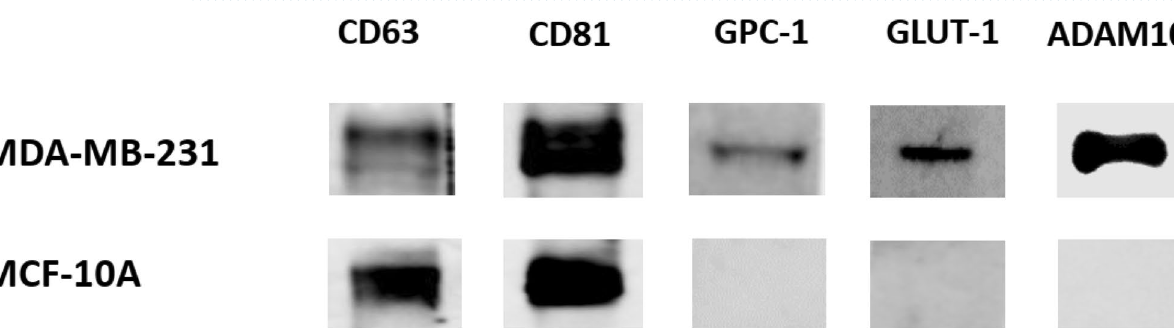
Figure 3. The relative abundance distribution of the 15 potential BC biomarkers over the whole identified proteome. Only abundant proteins, to the left of the dashed lines, were considered for validation.